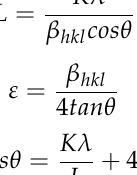
In the equation, the β hkl , L , K , λ , ε , and θ symbols indicate the full width at the half- maximum of the diffracted peak, indicating the broadening of a peak, the average particle sizes, a constant defined as the shape factor (=0.9), the wavelength of the CuK α radiation (1.5406 Å), the strain, and the angle of diffraction, respectively. From broadening XRD peaks, the particle sizes and strain associated with the samples of FeGaO-01 and FeGaO-02 were calculated by Equation (4), as shown in Figure 2a,b, respectively. The average particle size calculations were obtained from the diffraction peaks of (111), (202), (131), and (040). The crystallite sizes for the FeGaO-01 and FeGaO-02 samples were found as 14.4 nm and 12.0 nm, respectively. Furthermore, the microstrain of the particles was obtained by employing Equation (3), and the data are shown in Table 2. The microstrain values of the FeGaO-01 and FeGaO-02 samples, shown in Figure 2c,d, were calculated as 11.06 ± 06 × 10 − 2 and 1.1 ± 0.2 × 10 − 3 , respectively. The microstrain is associated with a lattice dislocation density [32]. The longer time milling causes the formation of a 10 times higher microstrain with particles.